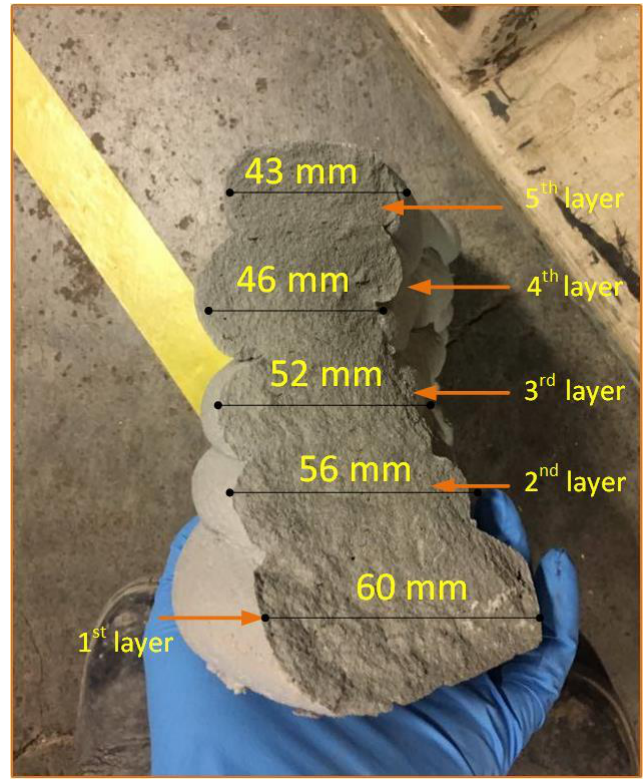
Figure 7. Cross-section of the details of the printed layers after crushing under a uniaxial compression load, using a cavity pump as a delivery system (nozzle Ø 50 mm).